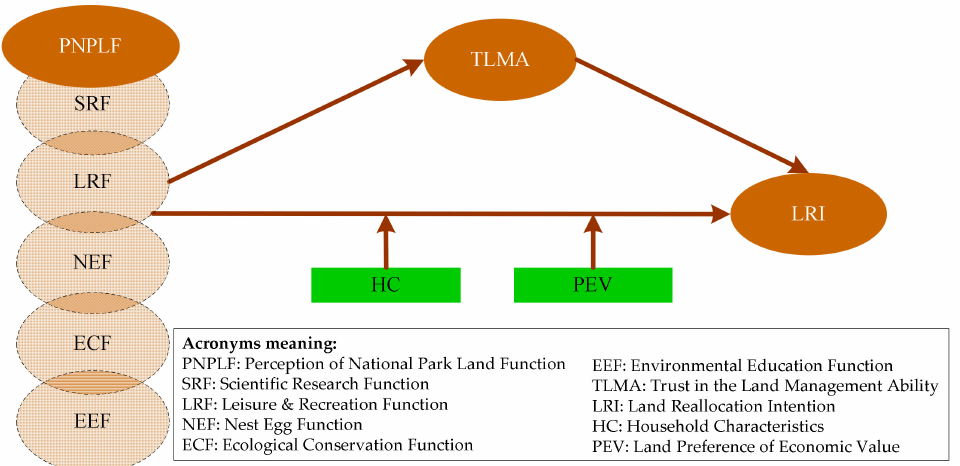
Figure 1. The conceptual